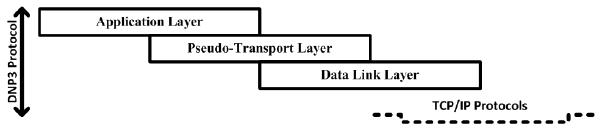
Figure 8. Logical interrelation and communication flow.